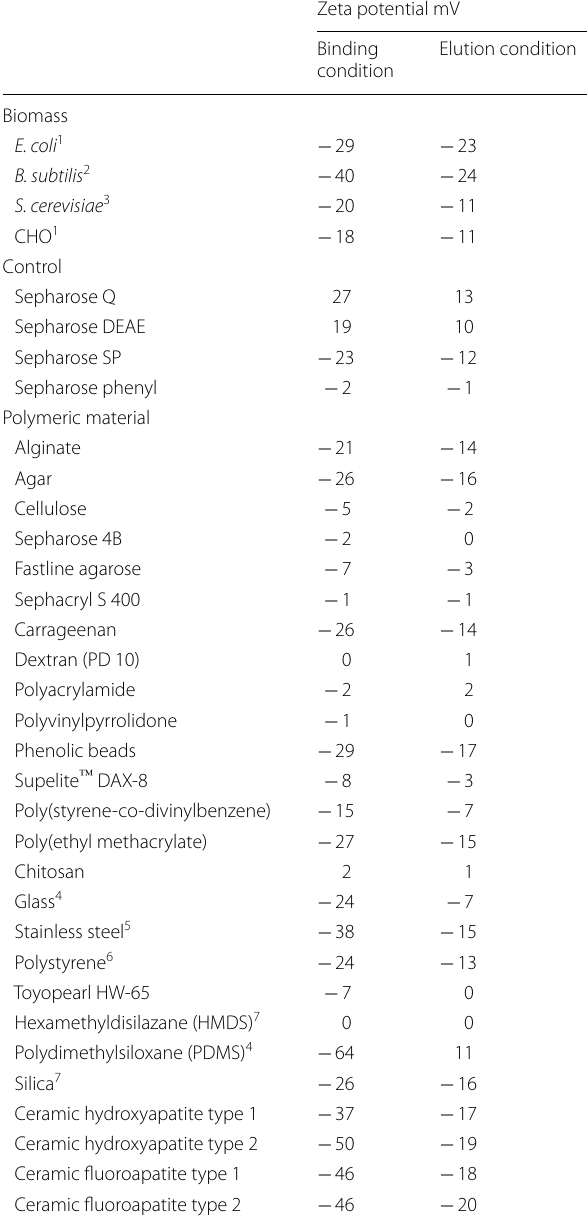
Table 4 Zeta potential values for biomass, control adsorbents and polymeric